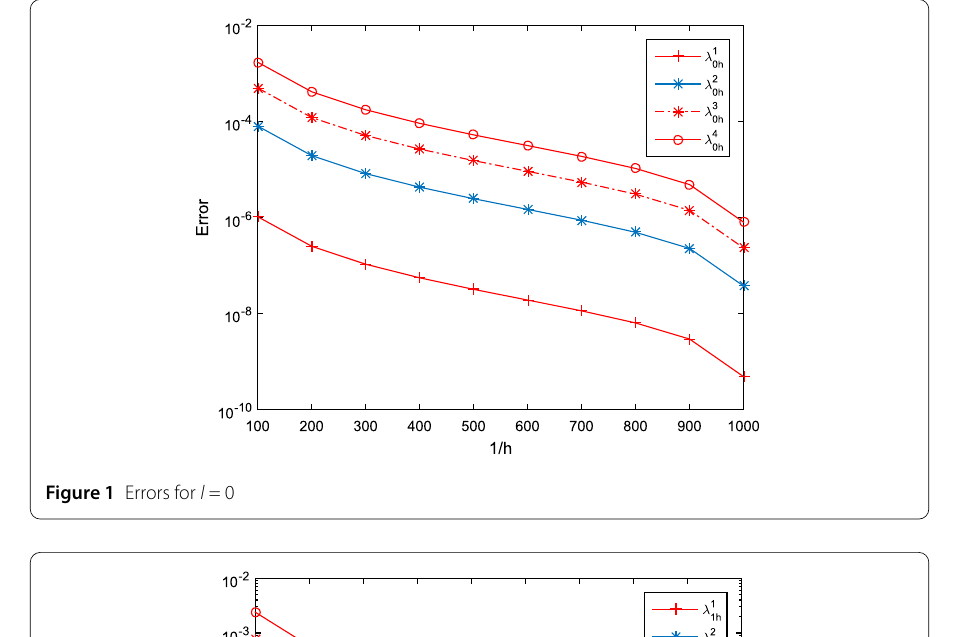
Figure 1 Errors for l = 0